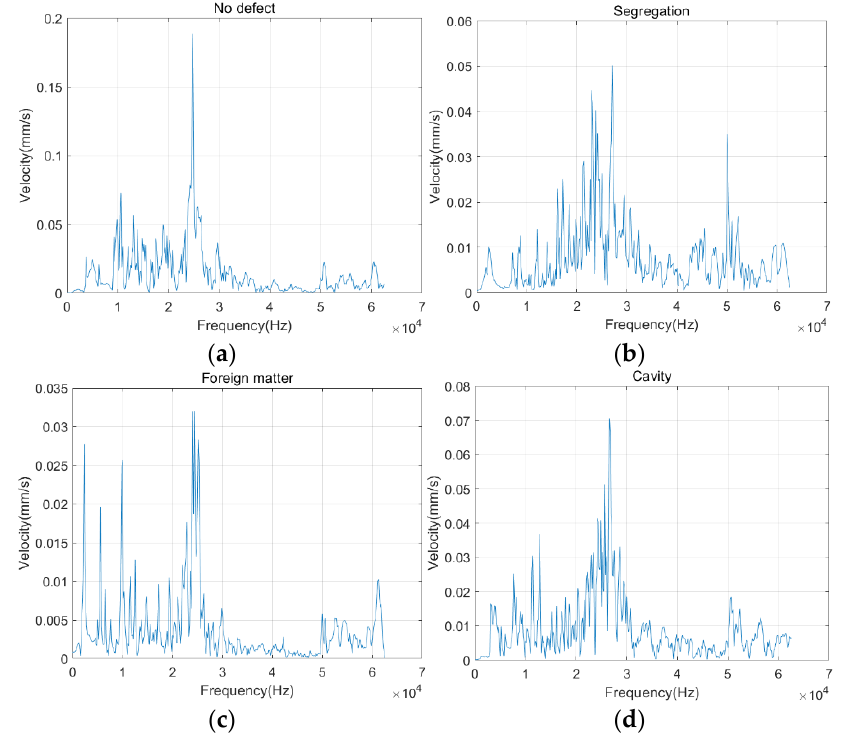
Figure 5. ( a ) No defect typical frequency spectrum; ( b ) Segregation typical frequency spectrum; ( c ) Foreign matter typical frequency spectrum; ( d ) Cavity typical frequency spectrum.